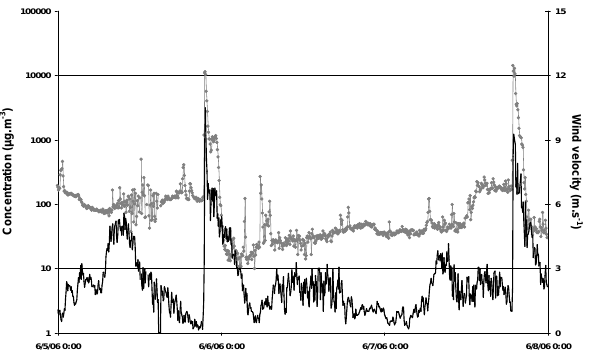
Fig. 16. 5-min PM 10 concentrations as a function of the 5-min sur- face wind velocities measured in MCS and no MCS conditions in Cinzana from 5 to 8 June